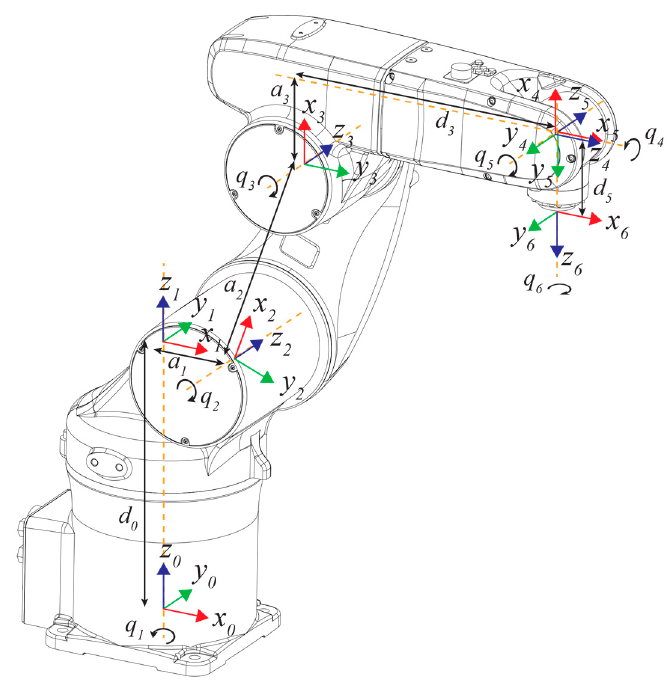
Figure 2. Robot reference frames.